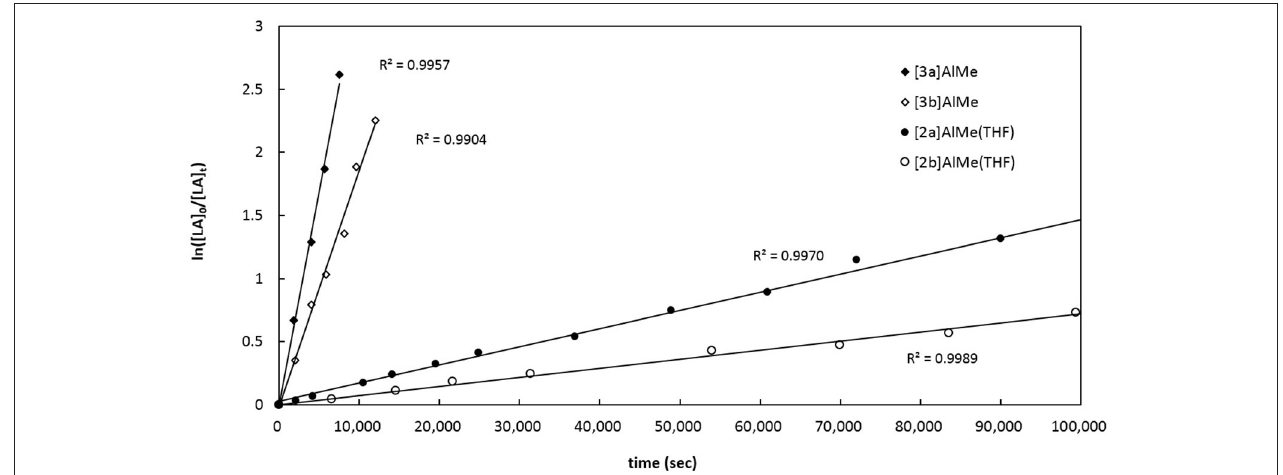
FIGURE 9 | Semilogarithmic plots of rac -LA conversion with time employing (i) [ 3a ]AlMe, k obs = 3.40 (13) × 10 − 4 s − 1 (ii) [ 3b ]AlMe, k obs = 1.87 (8) × 10 − 4 s − 1 (iii) [ 2a ]AlMe(THF), k obs = 1.44 (2) × 10 − 5 s − 1 (iv) [ 2b ]AlMe(THF), k obs = 7.19 (7) × 10 − 6 s − 1 . Conditions: [cat] 0 = [PhCH 2 OH] 0 = 6.7mM, [ rac -LA] = 670mM, toluene-